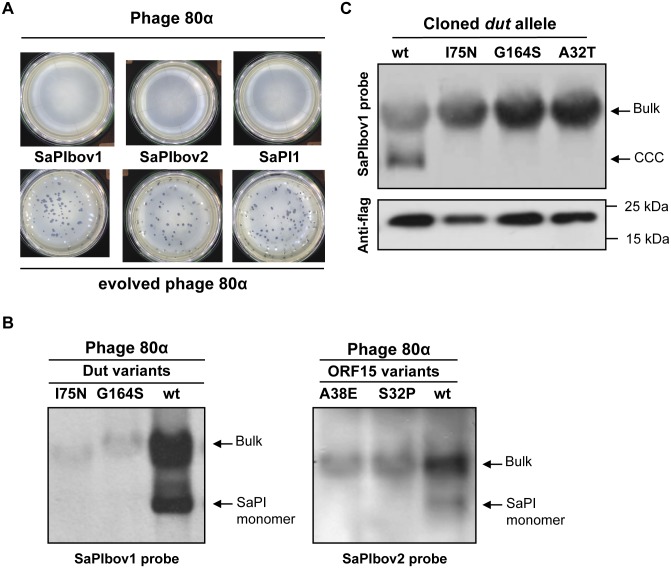
SaPI interference in evolved phages.(A) SaPI interference with phage reproduction. Approximately 108 bacteria were infected with 100 p.f.u. of phage 80α (upper panel) or an evolved 80α derivative carrying mutation in all three SaPI inducers (lower panel), plated on phage bottom agar, and incubated 24 h at 32°C. (B) Induction of SaPIbov1 (left) or SaPIbov2 (right) by evolved 80α phages carrying mutations in the dut or ORF15 genes, respectively. Samples from the different lysogenic strains were isolated 60 min after induction with mitomycin C, separated on agarose and blotted with a SaPIbov1- or SaPIbov2-specific probe. Upper band is ‘bulk’ DNA, including chromosomal, phage and replicating SaPI; lower band is SaPI linear monomers released from phage heads. (C) SaPIbov1 excision and replication after induction of cloned dut genes from different evolved phages. A non-lysogenic derivative of strain RN4220 carrying SaPIbov1 was complemented with plasmids expressing 3xFlag-tagged Dut proteins. One millilitre of each culture (optical density (OD)540nm = 0.3) was collected and used to prepare standard minilysates, which were resolved on a 0.7% agarose gel, Southern blotted and probed for SaPIbov1 DNA. In these experiments, because no helper phage is present, the excised SaPI DNA appears as covalently closed circular molecules (CCC) rather than the linear monomers that are seen following helper-phage-mediated induction and packaging. The upper panel is a Southern blot probed for SaPIbov1 DNA; the lower panel is a western blot probed with antibody (Sigma) to the Flag tag carried by the proteins.